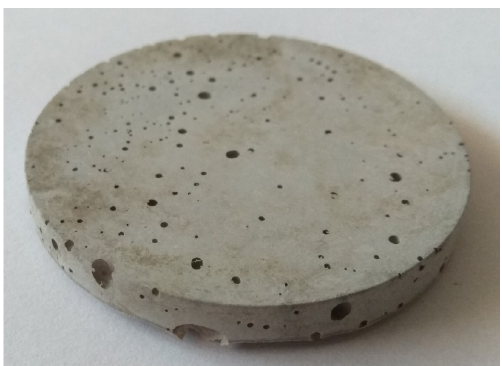
Figure 1. Concrete specimen (diameter 55 mm, height 5